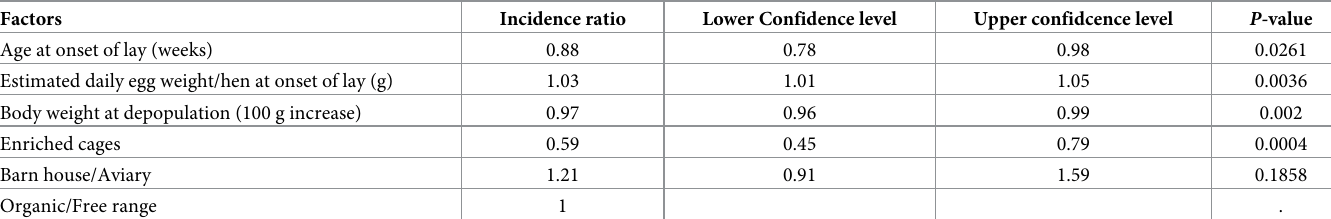
Table 14. Incidence ratios for risk factors with significant effect on the presence of keel bone factors in end of lay hens (n = 24 flocks).